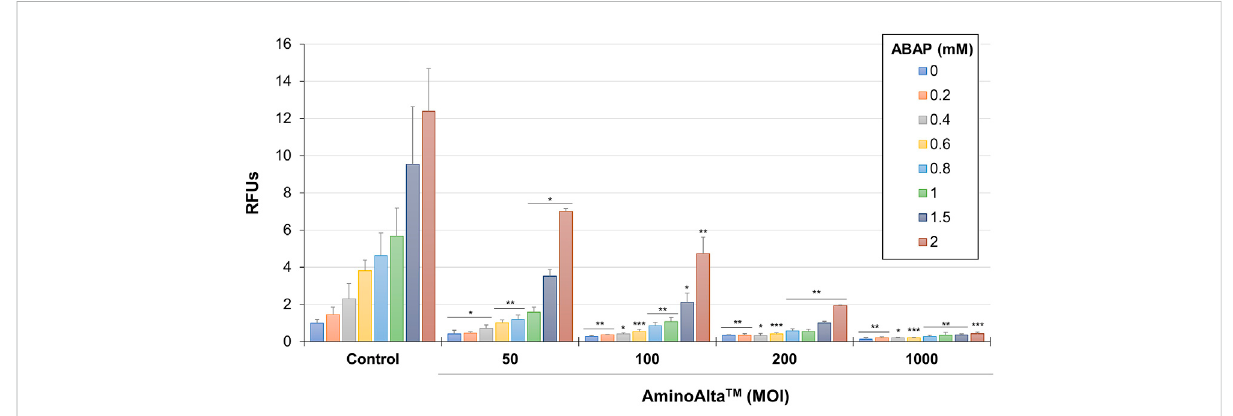
Cellular antioxidant activity of AminoAlta ™ assessed in Caco-2 cells damaged by different concentrations of 2,2 ′ -azobis (2- methylpropionamidine) dihydrochloride (ABAP). Control, Caco-2 cells without AminoAlta ™ treatment. RFUs, relative fl uorescence units. MOI, multiplicity of infection. Asterisks indicate statistically signi fi cant difference compared to the corresponding control as determined through a two- tailed unpaired Student ’ s t-test. *, p < 0.05; **, p < 0.01; ***, p <